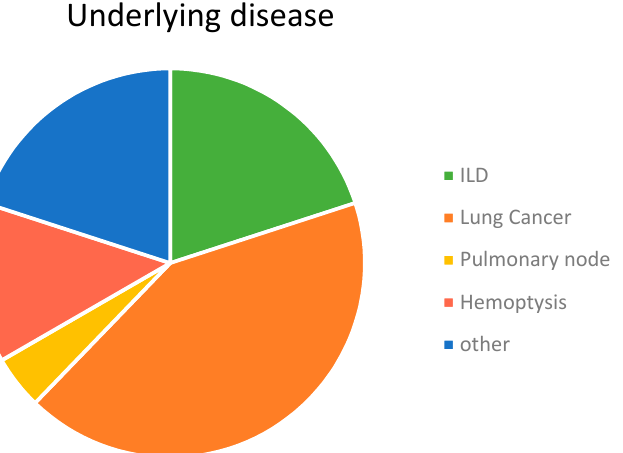
Figure 1. Distribution of patients according to the clinical situation that indicated the bronchoscopy. Others included: Wegener syndrome, dysnea, thymoma, TBC sequels, atelectasis, lung infiltrate, tracheal stenosis, Hodking and and Non-Hodgkin lymphoma, COPD, and cough.